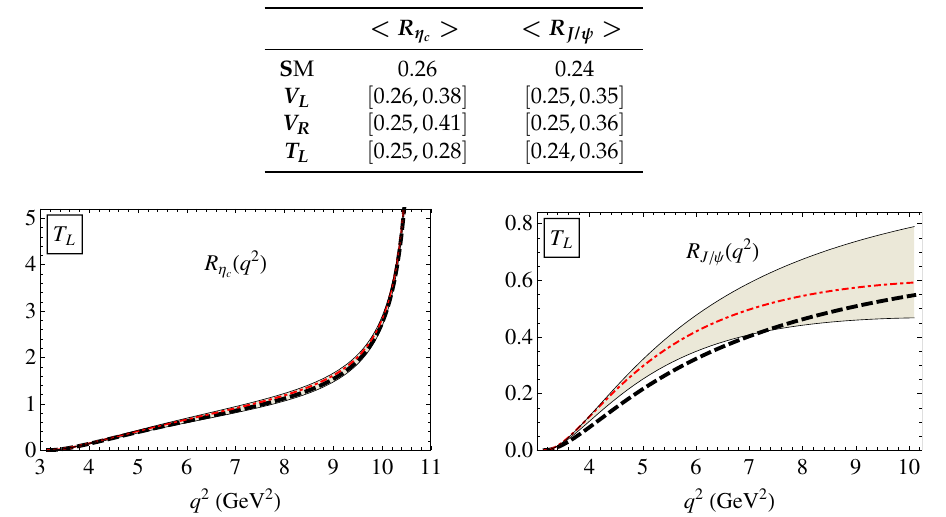
Table 3. The q 2 average of the ratios in the Standard Model (SM) and in the presence of New Physics (NP).